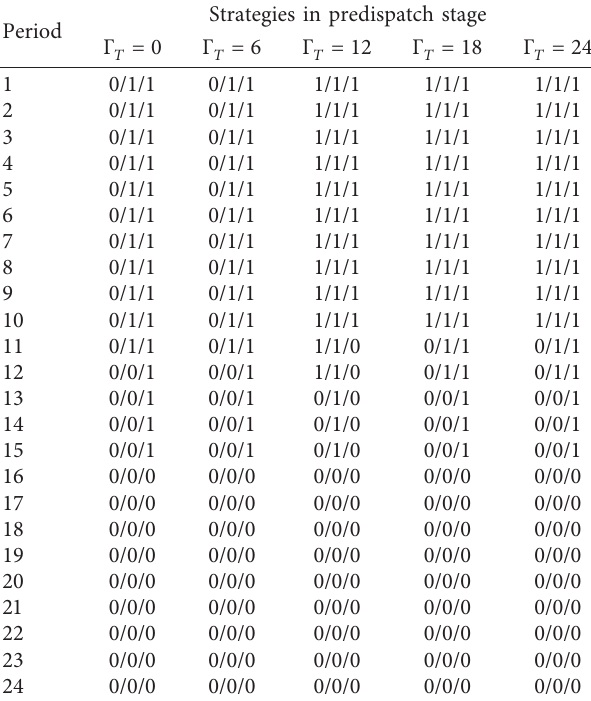
Table 7: Prescheduling strategies for the status of DGs at various Γ values ( Γ S � 3).